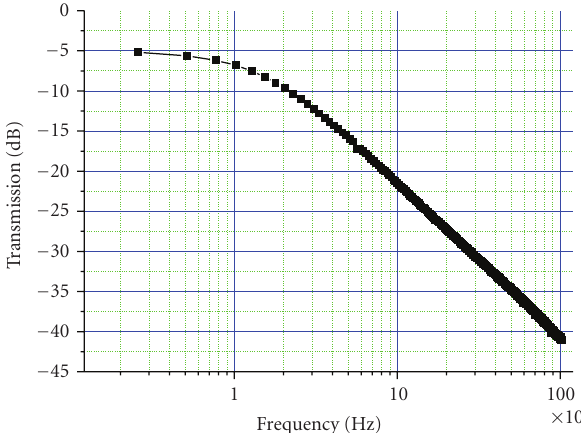
Figure 3: The measured transmission of the 2m-long resistive wire pair.